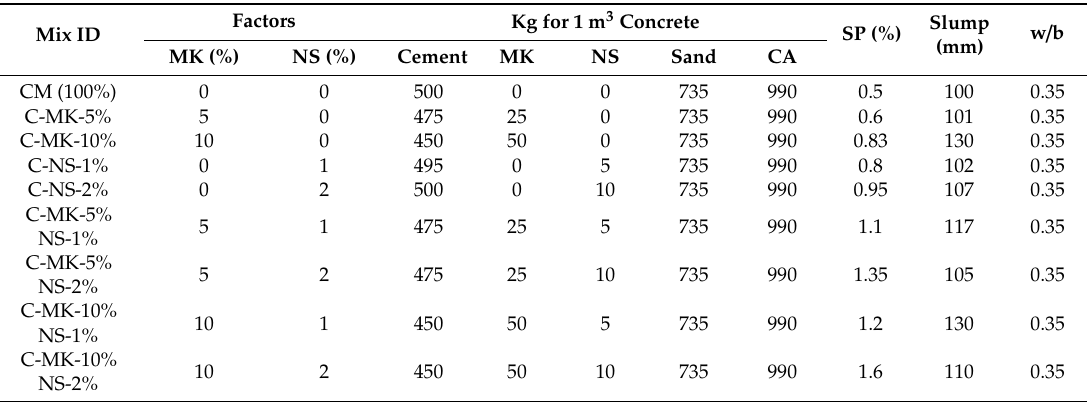
Table 3. Mix proportions containing MK and